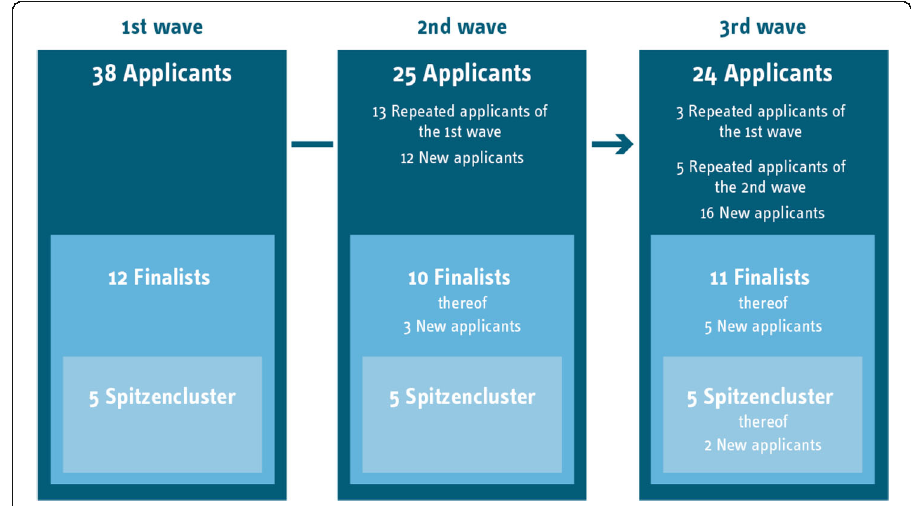
Fig. 1 Structure of the participants in the three selection waves of the Leading-Edge Cluster Competition. Source: Accompanying evaluation of the LECC. – Abbreviations: In the 2nd wave of the competition, two initiatives from the 1st wave entered a joint application. One repeated applicant from the 2nd wave also took part in the 3rd